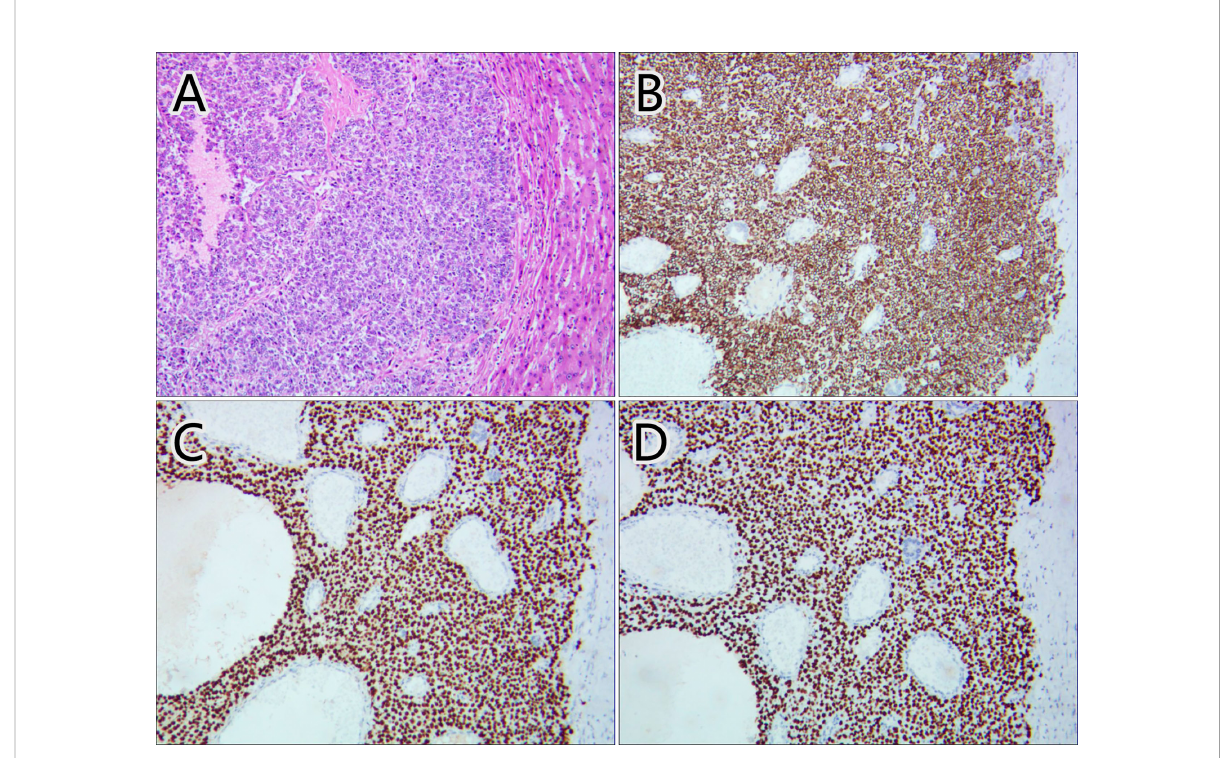
FIGURE 3 Pathological images of the hepatic mass. Hematoxylin – eosin staining (A) and immunohistochemical staining of CK5/6 (B) , P63 (C) , and P40 (D) con fi rmed the mass as metastatic squamous cell